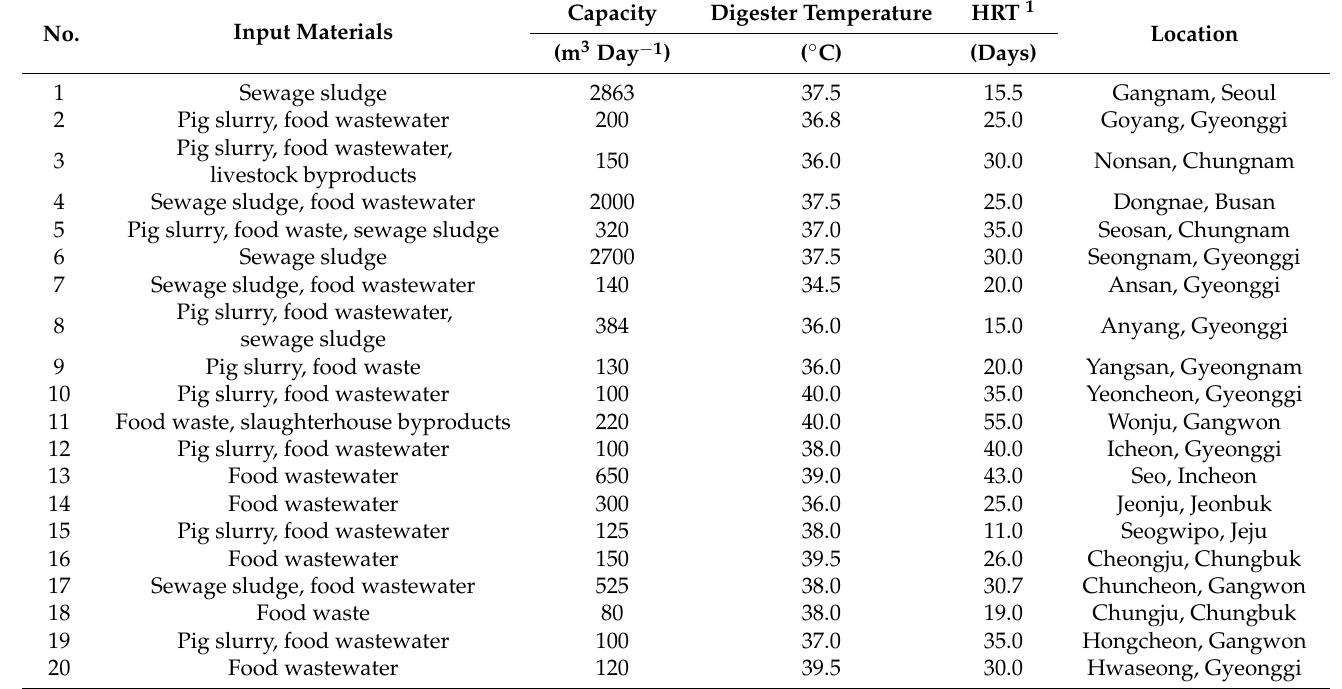
Table 1. Operating status of the facilities investigated in this